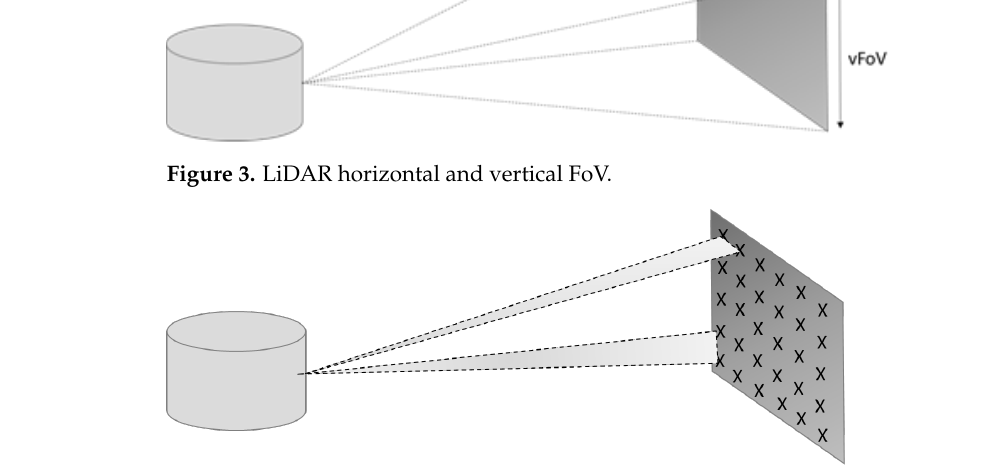
Figure 4. LiDAR horizontal and vertical